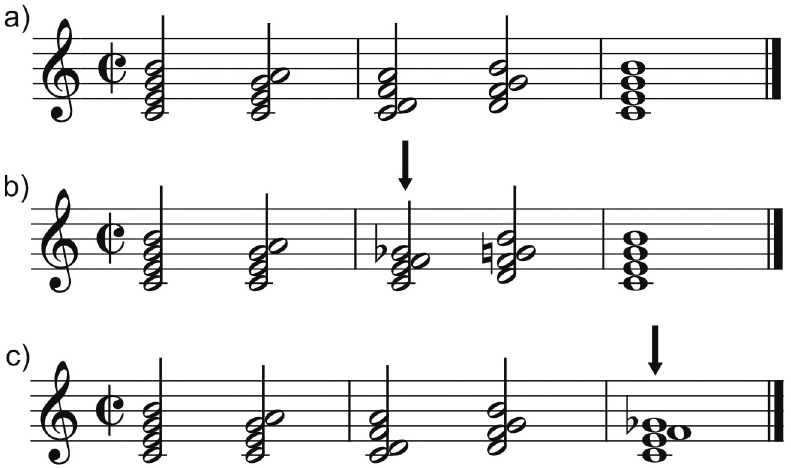
Fig 1. Examples of chord sequences in root position. Dissonant clusters are indicated by black arrows. a) Cadences consisting of in-key chords that resolve to the tonic. b) Cadences containing a dissonant cluster in the third position. c) Cadences containing a dissonant cluster in the fifth